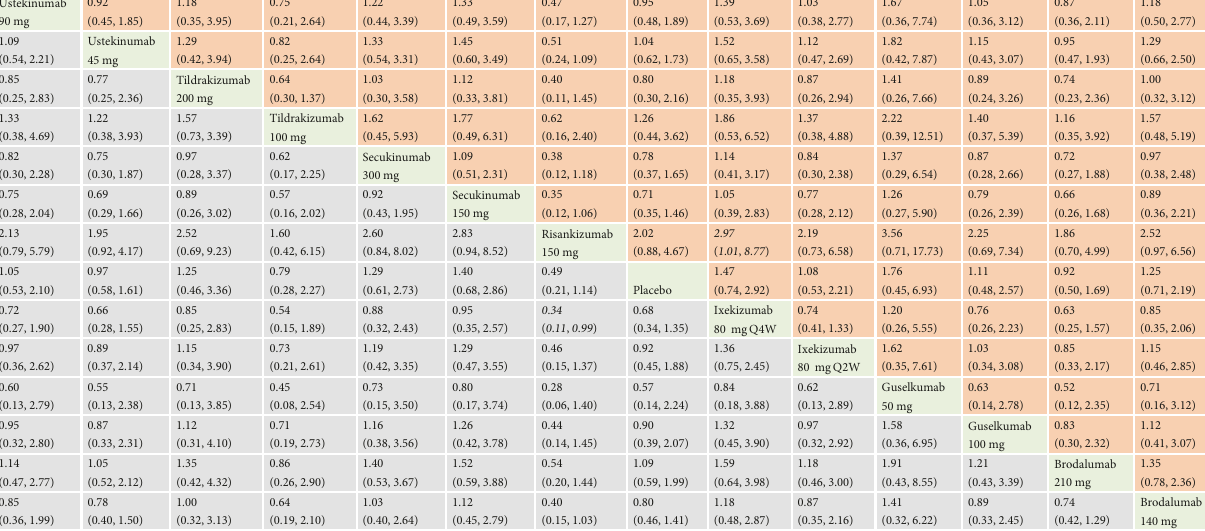
Figure 8: Relative risk with 95% CIs of all interventions from network meta-analysis for serious adverse events (sAEs). Di ff erent interventions in the middle block divide the graph into upper and lower triangles; for the lower triangle, the e ffi cacy estimate is the ratio of the column de fi ning treatment to the row de fi ning treatment. In case that the con fi dence interval does not include 1, if RR > 1 , it favors the row de fi ning treatment. In contrast, if RR < 1 , it favors the column de fi ning treatment. The upper triangle is symmetrical to the lower triangle. The e ffi cacy estimate is the ratio of the row de fi ning treatment to the column de fi ning treatment. The results are mutually reciprocal. Statistically signi fi cant results have been applied with italic formatting.